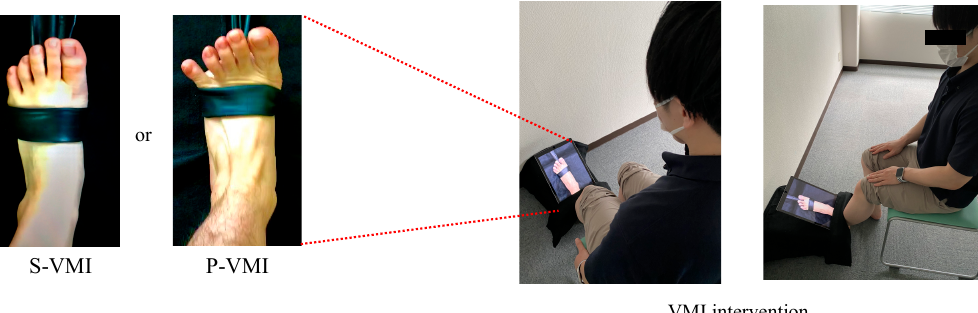
Figure 1. VMI intervention. (1) TheraBand: A TheraBand was used to apply resistance to the ankle dorsiflexion movement. (2) S-VMI: A TheraBand was wrapped around the foot, but no tension was applied. (3) P-VMI: Resistance was applied to the foot using the TheraBand to perform dorsiflexion with maximum effort. (4) Tablet computer: Videos of the ankle joint dorsiflexion movements of either S-VMI or P-VMI were projected on a tablet computer. (5) VMI intervention: Participants observed the video in a sitting position for 5 min. In P-VMI, strong contraction of the tibialis anterior muscle, extension movement of the toes, and activity of the extensor hallucis longus muscle tendon and extensor digitorum longus muscle tendon were clearly observed compared to S-VMI. Abbreviations: P-VMI, Power-VMI; S-VMI, Standard-VMI; VMI, visual-motor illusion.